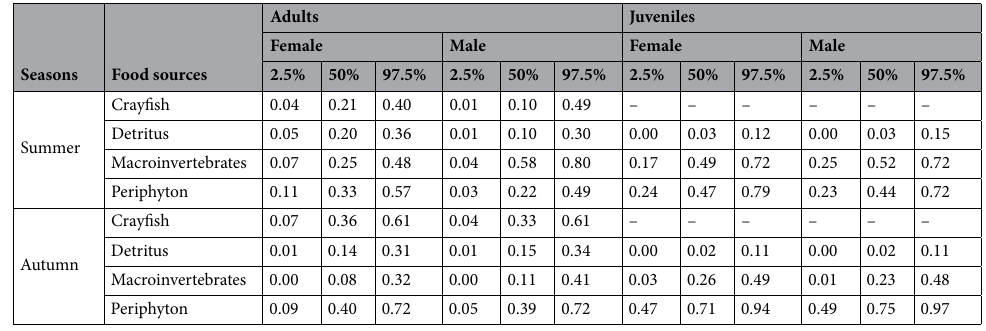
Table 3. Food source usage proportions for adult and juvenile signal crayfish in Valla Stream in summer and autumn, represented by the median diet (50% quantiles) and its 95% confidence